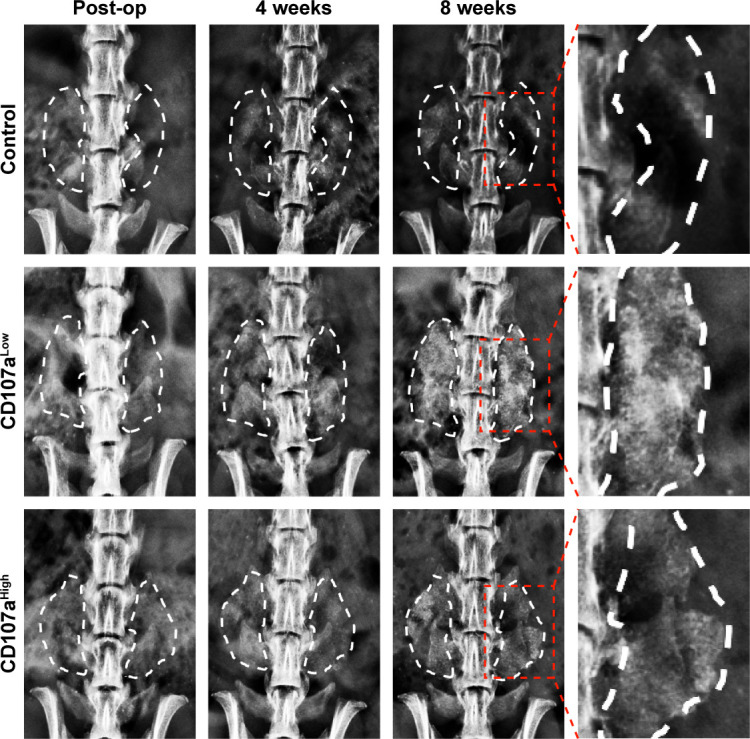
High-resolution roentgenography (XR) demonstrates ossification of spinal fusion implants within CD107alow treated sites.Representative postero-anterior XR images of the lumbar spine post-operatively (far left), 4 weeks (middle left), and 8 weeks (middle and far right) after implantation. See Supplementary file 6 for animal allocation.